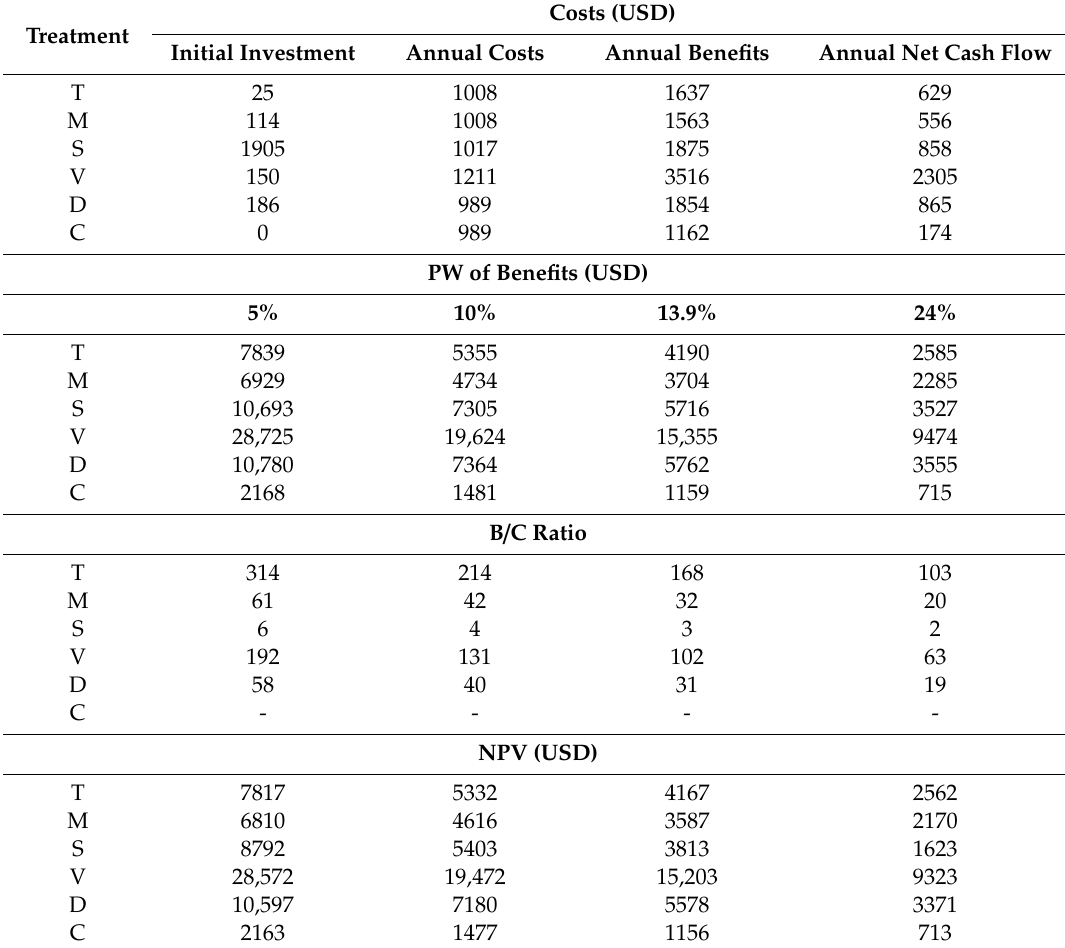
Table 4. Costs and economic indicators of di ff erent fertilizer treatments on